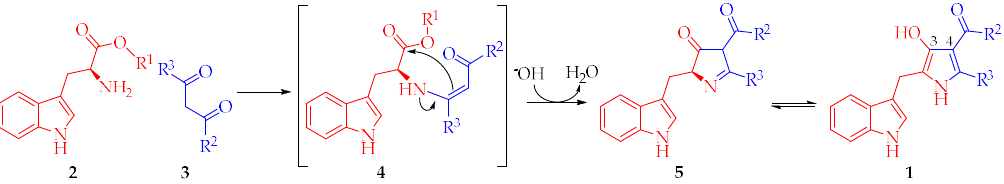
Figure 1. Optimized molecular structure of compound 1a using DFT-B3LYP calculations at the 6-31G(d,p) level.